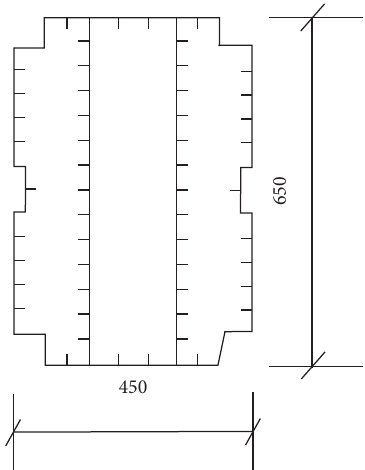
Figure 3: Single-sided cross section of the second